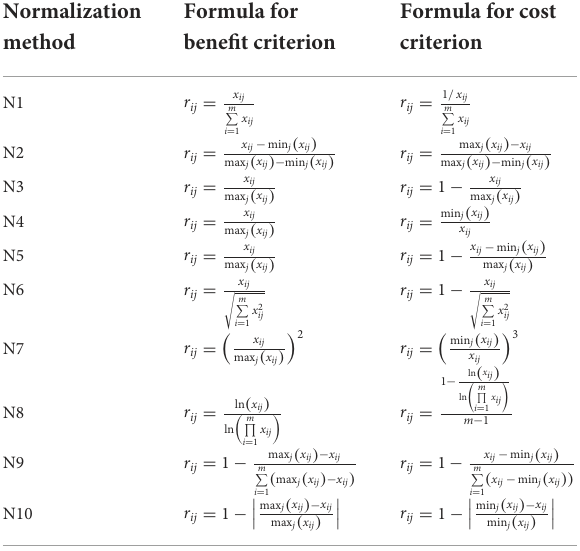
Formula for benefit criterion